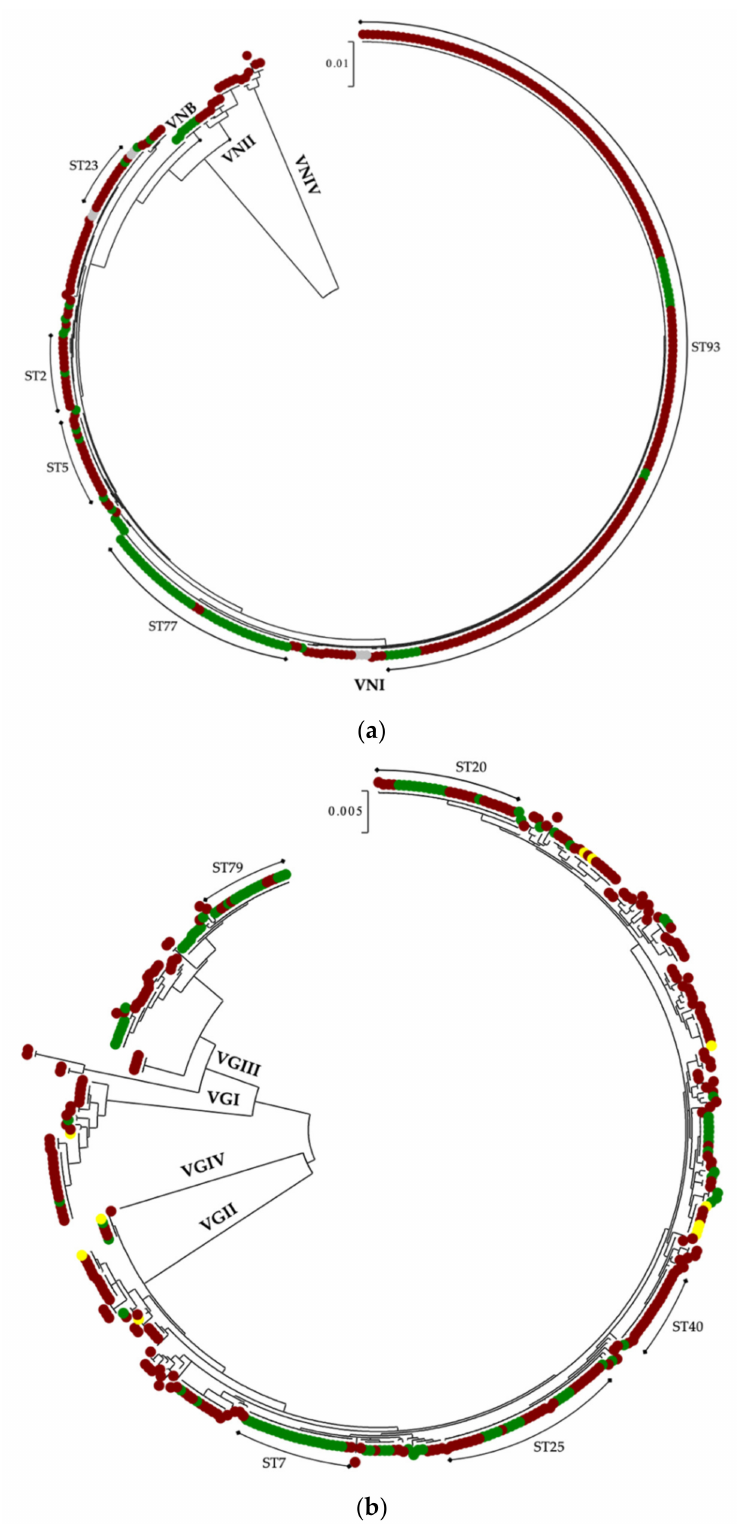
Figure 2. Dendrograms showing the genetic relationship of clinical (red), environmental (green), and veterinary (yellow) ( a ) Cryptococcus neoformans species complex ( n = 367) and ( b ) Cryptococcus gattii species complex ( n = 400) isolates from Latin America, according to multilocus sequence typing (MLST) data. The five most common sequence types, ST93, ST77, ST2, ST5, and ST23 for C. neoformans , and ST25, ST20, ST7, ST79, and ST40 for C. gattii , are indicated in each dendrogram. Isolates from an unknown source are indicated in